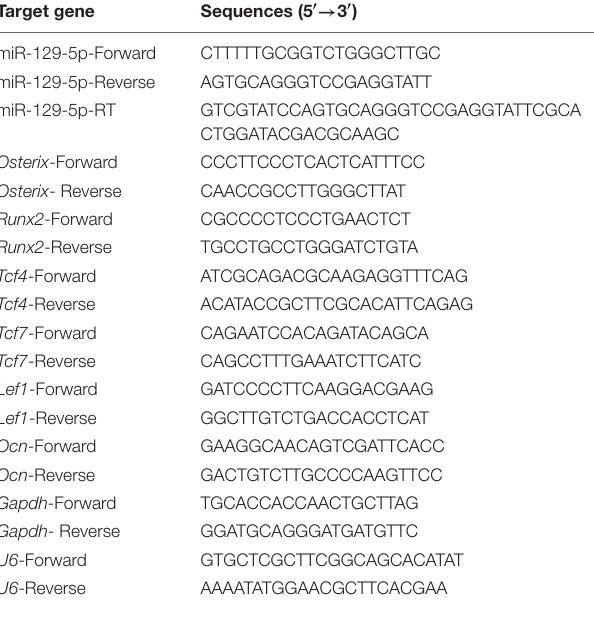
TABLE 2 | Primer Sequences for qRT-PCR. Target